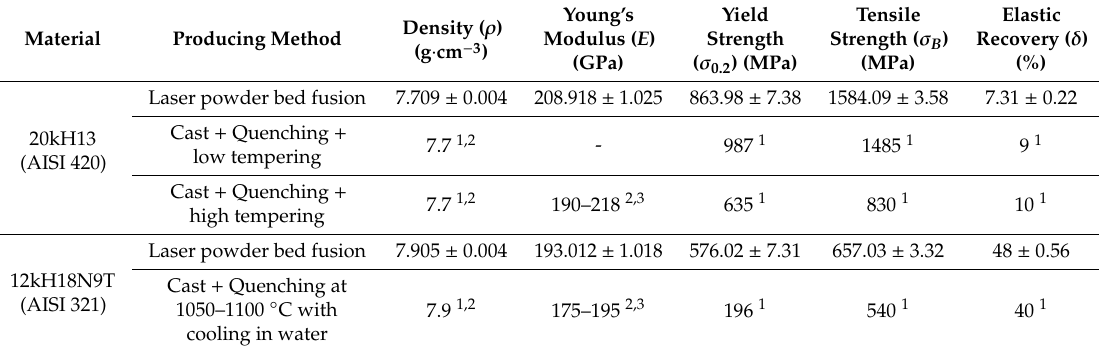
Table 4. Physical and mechanical properties of 20kH13 (AISI 420) and 12kH18N9T (AISI 321) steel samples produced by laser powder bed fusion in comparison with the data obtained for traditionally produced samples.